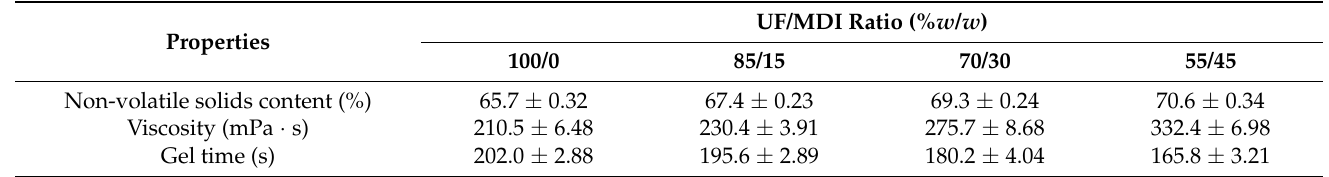
Table 1. Basic properties of hybrid UF/MDI